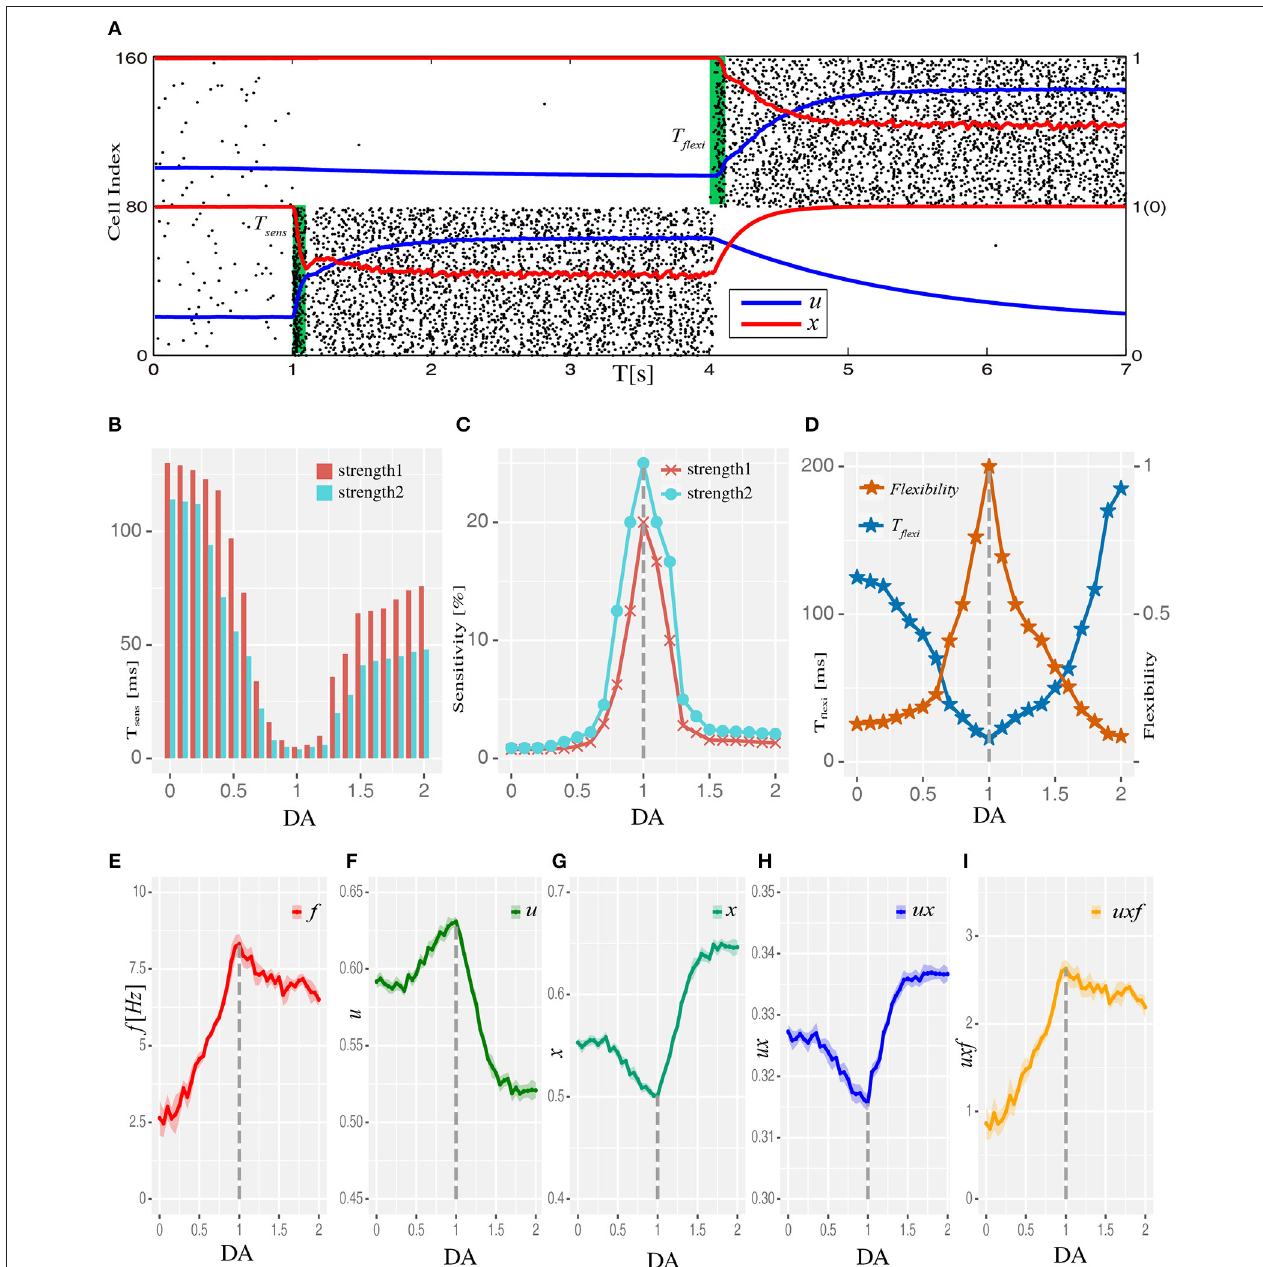
FIGURE 2 | Dopamine modulation and the optimal working memory performance. (A) One item is loaded into memory from the resting state and updated to another item by applying item-specific stimuli (green shading) with a durations of T sens and T flexi , respectively. Black dots are neural spikes (only 10% neurons are shown). u and x donates average utilization parameter and available resource in corresponding populations, respectively. (B) The shortest stimulation time ( T sens ) needed for the model to load the stimulus into WM from resting state at each D1 activation level. Results for two stimulus strengths (strength1 < strength2) are shown. (C) Sensitivity of WM, defined as the reciprocal of T sens , exhibits an inverted-U profile with dopamine D1 modulation. (D) The shortest time ( T flexi ) needed to update a memory item and corresponding flexibility were also shaped by the U and inverted-U profiles, respectively. (E–I) Internal parameters that determine the system’s dynamics change as a function of D1 activation, including firing rate f (average firing rate), u (utilization parameter), x (available resources), ux (transmitters used per spike), and uxf (total transmitters used) of the population receiving memory stimuli (strength1, and in total 200ms long), which was E s1 for all analyses presented in this paper. Data are represented as mean S.D. across all the neurons in the ±